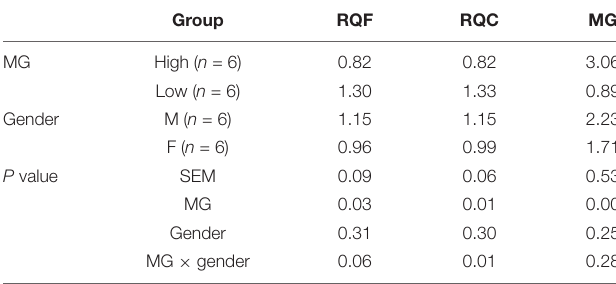
TABLE 1 | The relative quantification (RQ) of mRNA levels of FOSL2 and CEBPB in BJY chicken HMG and LMG